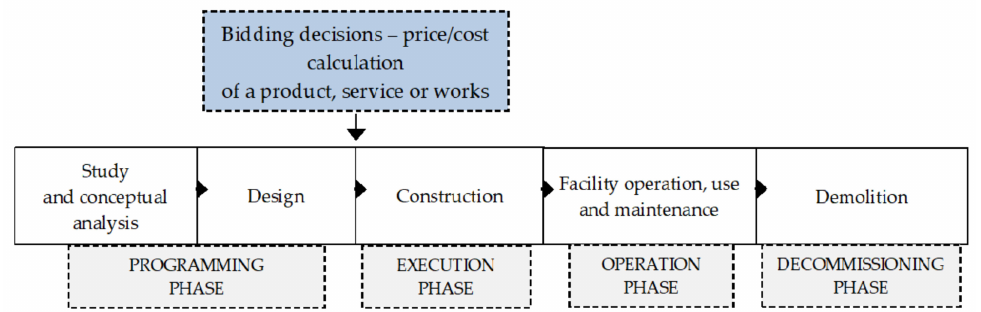
Figure 1. Bidding decisions of the building contractor within the building life